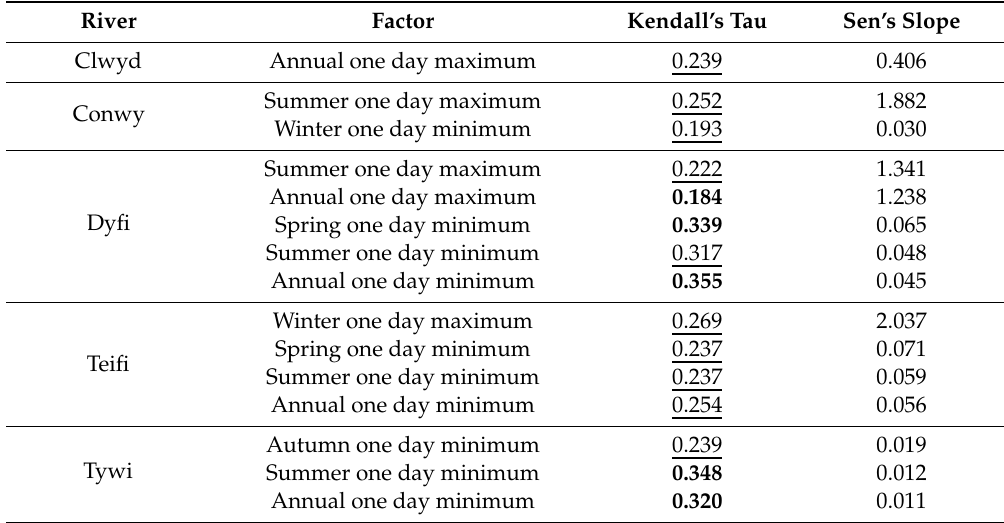
Figure 5. Annual average streamflows for all study catchments, with linear trend lines also shown (dashed lines). The only statistically significant trend, an increase in streamflow in the Teifi catchment, is highlighted in red. Table 5. Mann-Kendall trend analysis and Sen’s slope indicator results for statistically significant trends in extreme streamflow events (1982–2015). Values for Kendall’s Tau underlined are significant at p <0.05, and those in bold are significant at p <0.01